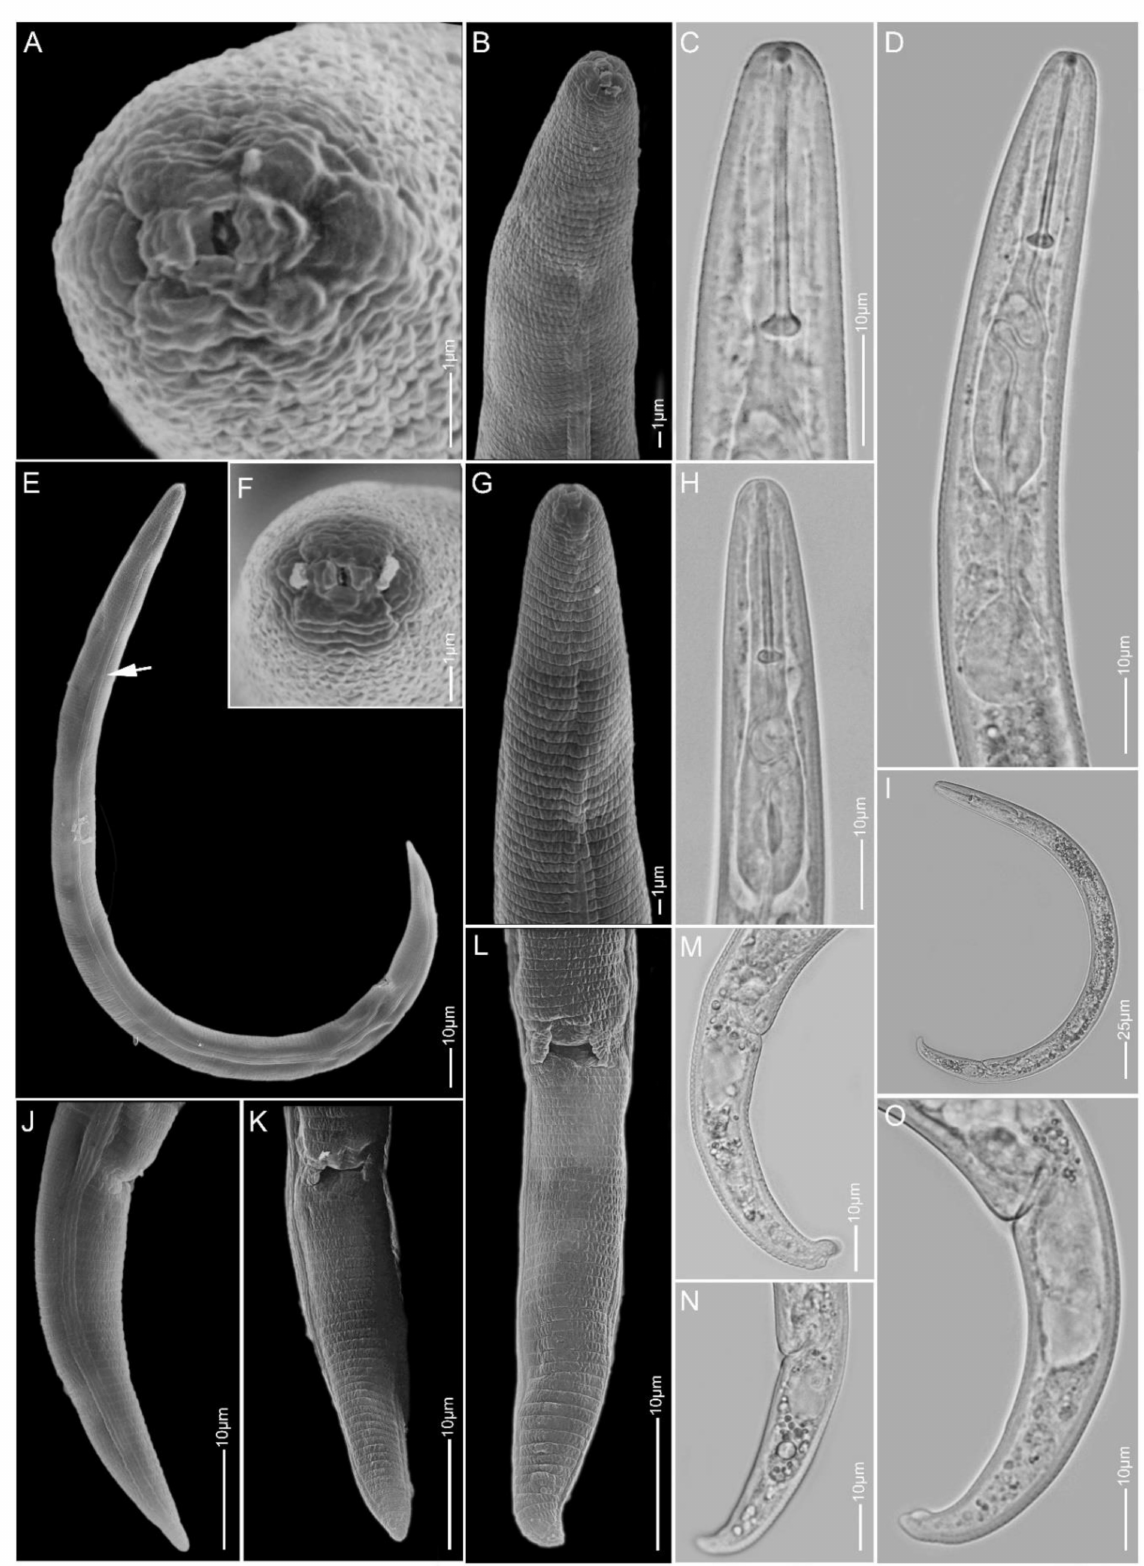
Figure 4. Light and scanning electron microscopy images of Paratylenchus holdemani females: ( A , F ) face view; ( B – D , G , H ) anterior region; ( E , I ) total body; ( J – O ) tail region; arrow pointed to deirid in ( E